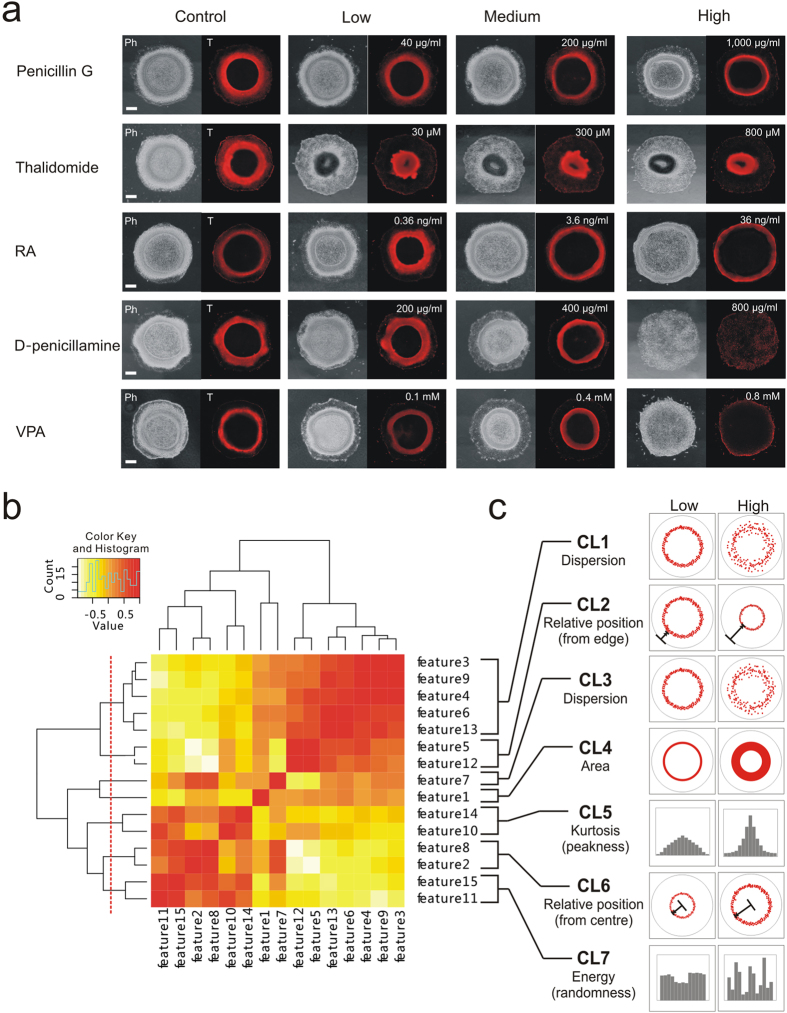
Generation of morphologic clusters by unsupervised feature clustering.(a) Phase and T immunofluorescence images of μP-hPSC colonies in different drug test groups on day 3. Scale bar, 200 μm. (b) Hierarchical clustering of morphologic attributes based on feature correlations. Dash line indicates that 7 clusters were acquired. (c) Graphical interpretations of the 7 morphologic clusters to describe changes to the annular mesoendoderm pattern.